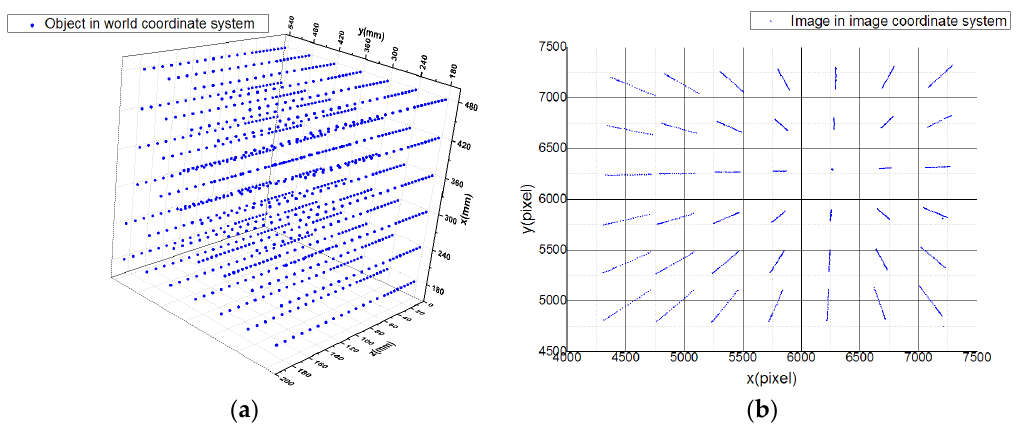
Figure 5. Calibration data set: ( a ) world coordinates and ( b ) image coordinates.